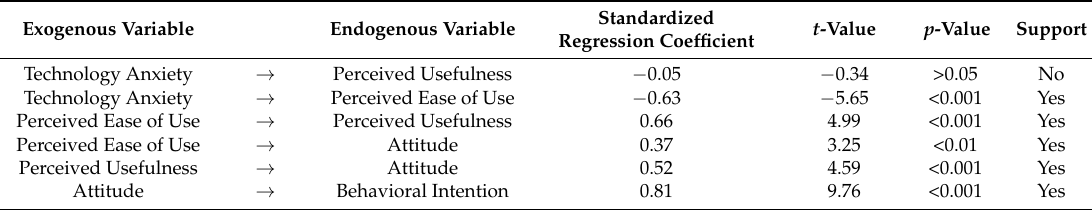
Table 2. Summary of hypothesis tests.